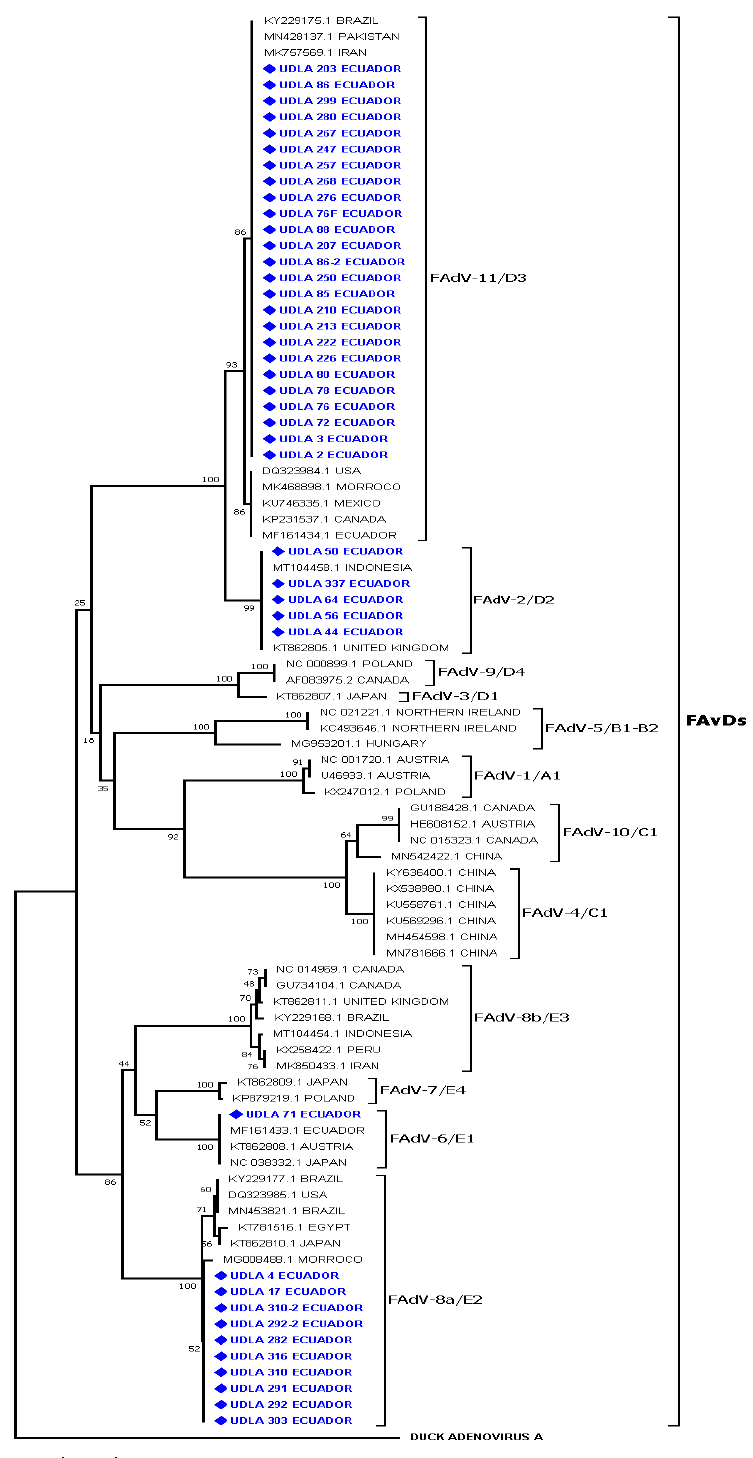
Figure 2. The phylogenetic comparison was performed using the sequences obtained from a portion of the HEXON gene in the present study and other FAdV sequences of many genotypes present in GenBank. Sequences were aligned using the CLUSTAL W method in ClustalX2 2.1. The phylogenetic tree was built using MEGA 7 software. Numbers along the branches refer to bootstrap values for 1000 replicates. The scale bar represents the number of substitutions per site. Duck adenovirus A (NC_001813.1) was used as the outgroup. The FAdV sequences in blue and marked with diamonds were obtained from the jejunum of Ecuadorian chicken flocks exhibiting signs of enteric disorders.